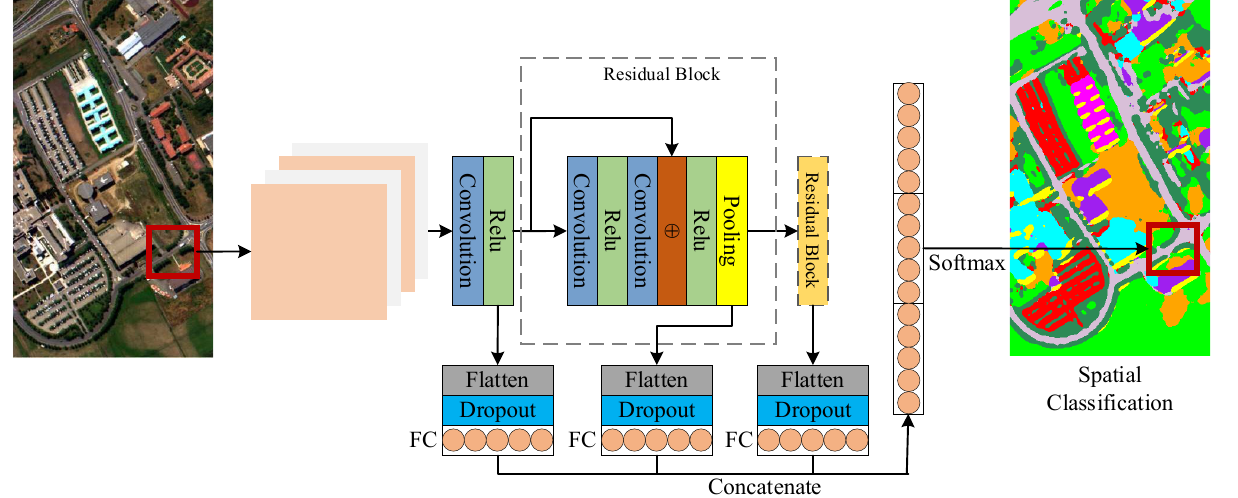
Figure 1. Architecture of the proposed